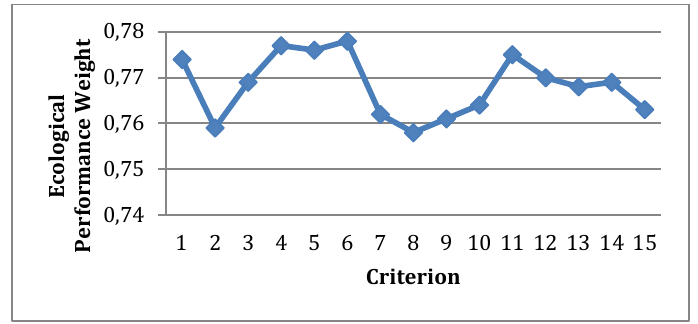
Figure 19: Ecological remanufacturing performance assessment criteria